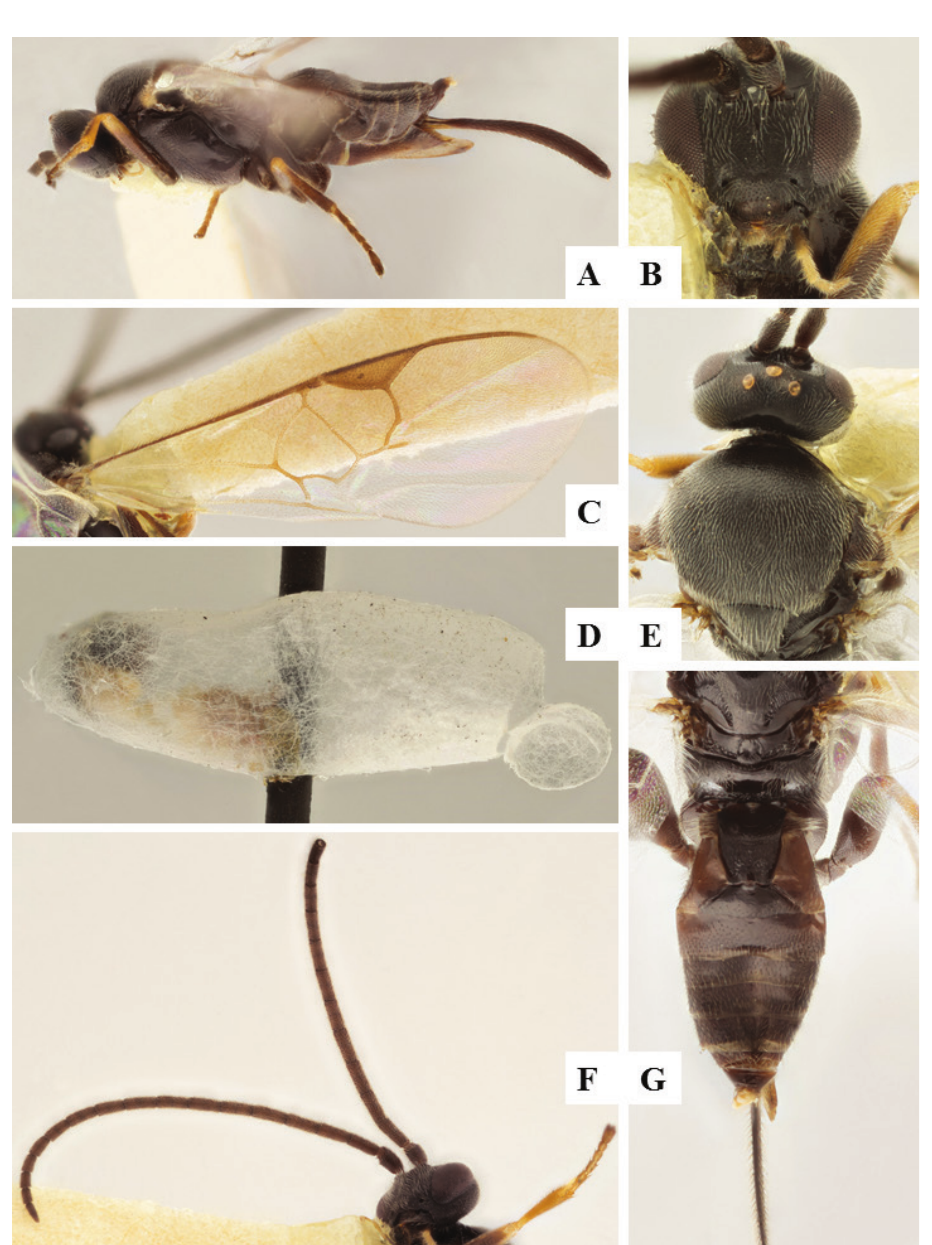
Figure 8. Apanteles laricellae. A Habitus, lateral B Head, frontal C Wings D Head and mesosoma (partially), dorsal E Metasoma, lateral F Metasoma, dorsal F Mesosoma,